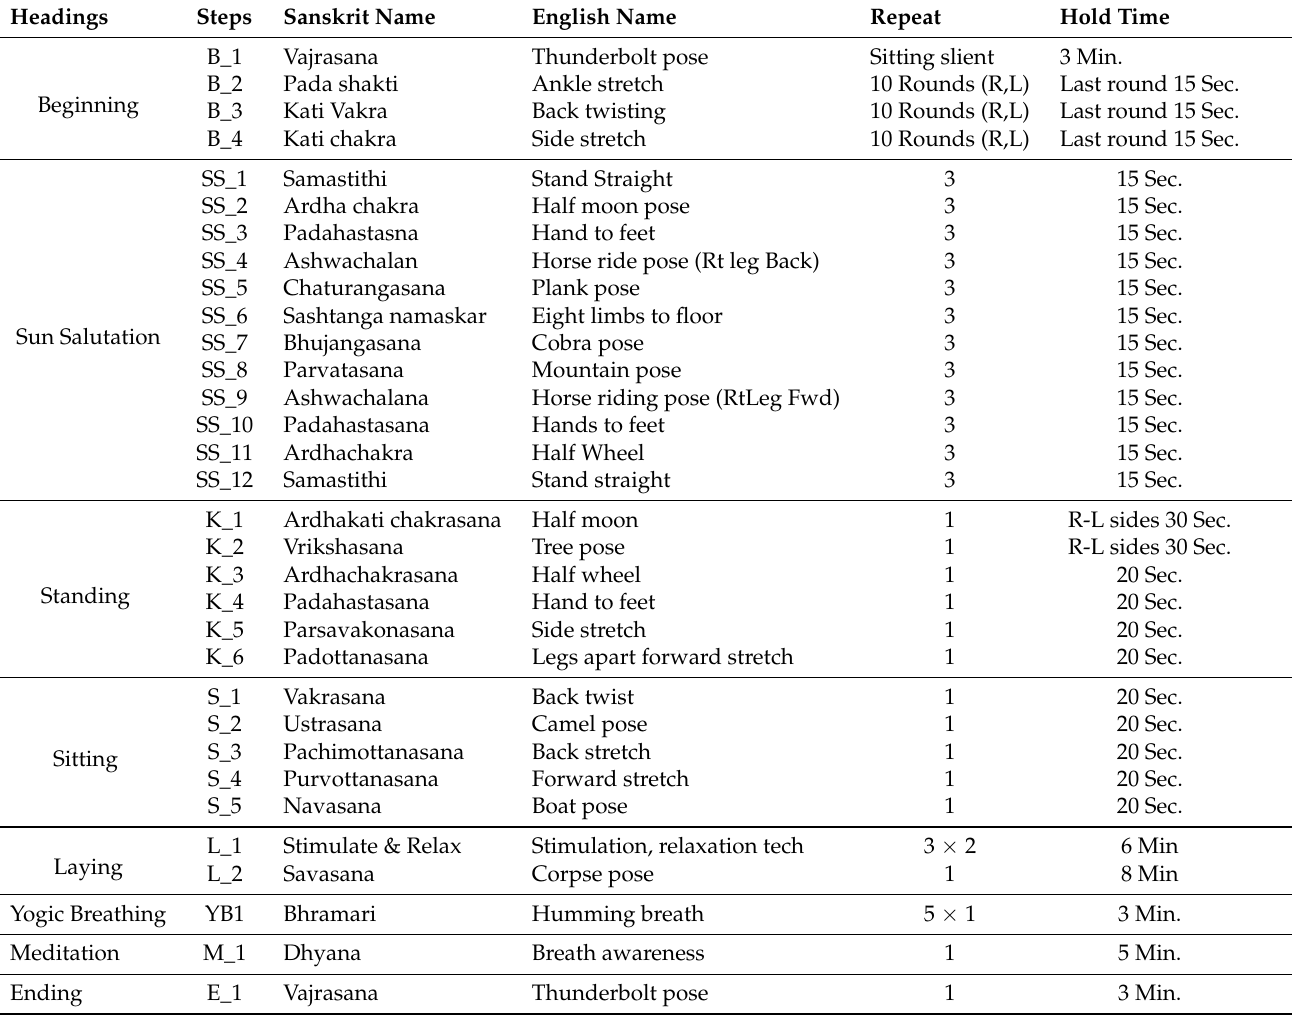
Table 1. Mano Shakti Yoga (MSY) protocol designed for training session to handle